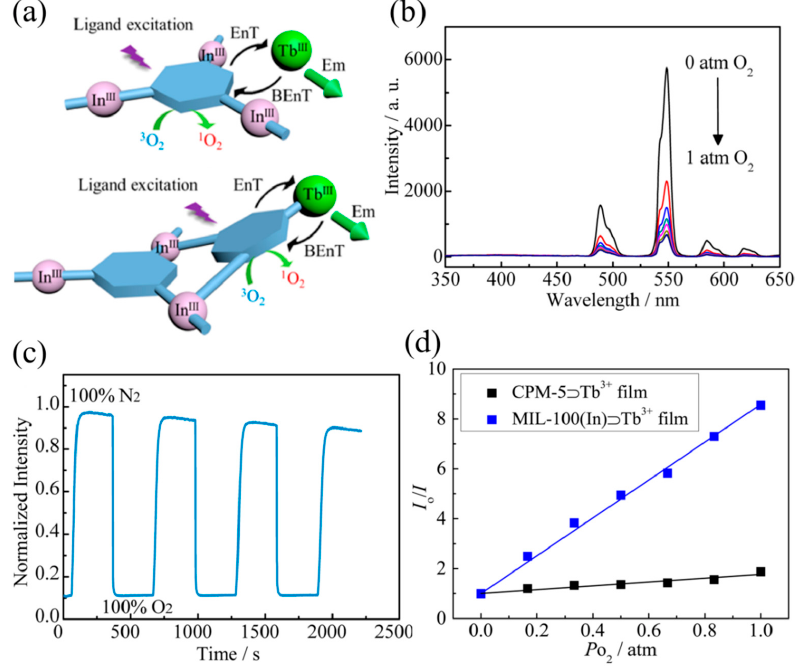
Figure 20. ( a ) Energy transfer process and O 2 quenching process of CPM-5 ⊃ Tb 3+ (upper) and MIL-100(In) ⊃ Tb 3+ (lower); ( b ) Emission spectra of activated MIL-100(In) ⊃ Tb 3+ films under different oxygen partial pressures P O2 ; ( c ) Reversible luminescence quenching of the MIL-100(In) ⊃ Tb 3+ film upon alternating exposure to 1 atm of O 2 and N 2 ; ( d ) Stern − Volmer plots showing I 0 / I vs oxygen partial pressure P O2 for the two activated MOF films. Reprinted with permission from Reference [94]. Copyright 2014 the American Chemical Society (Washington, DC,